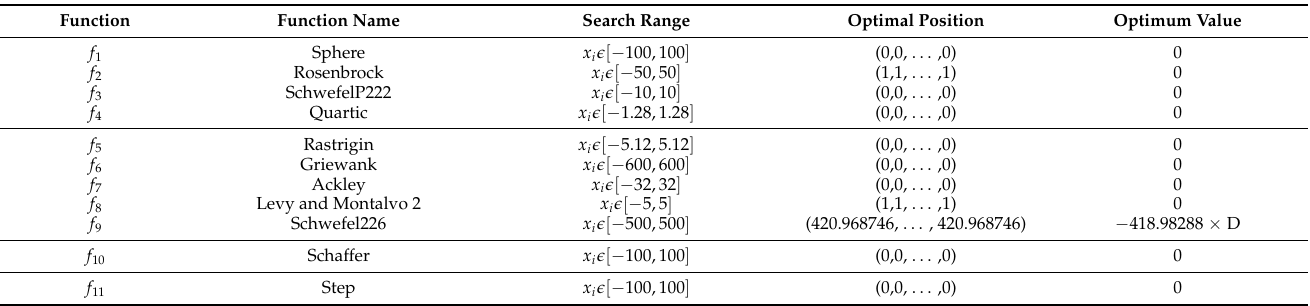
Table 1. Benchmark test functions.